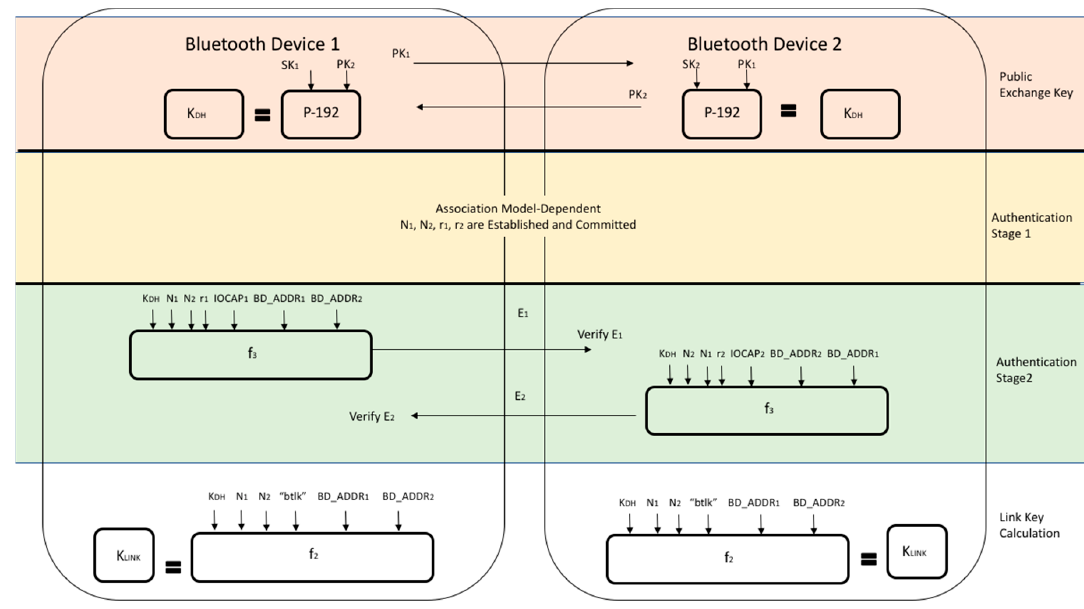
Figure 5. Link-Key Establishment for SSP.